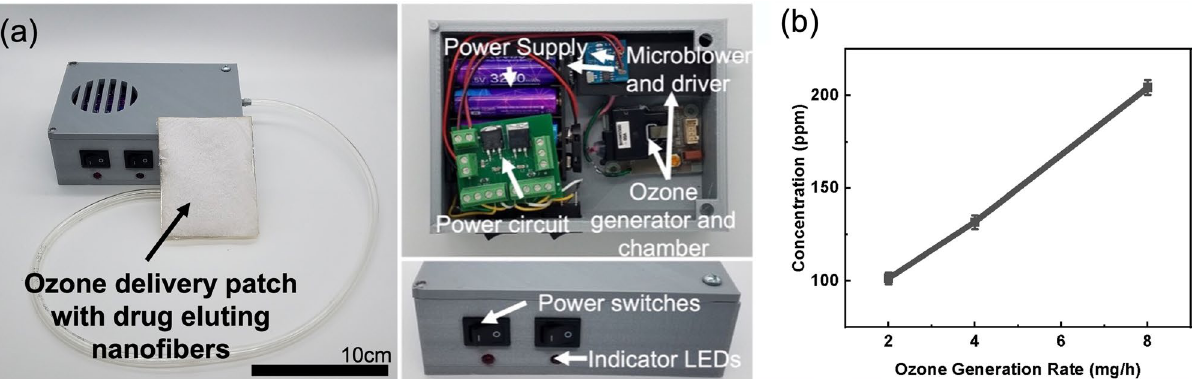
Figure 2. Portable adjunct ozone and topical antibiotic therapy system. ( a ) Ozone wound treatment system designed to administer adjunct ozone and antibiotic therapy topically to dermal wounds. System comprised of portable ozone generation system with microblower for ozone delivery and a porous mesh of drug-eluting PVA nanofibers for antibiotic delivery. Portable rechargeable system is fitted to custom housing and utilizes onboard low-power electronics for. ( b ) Relationship of concentration of ozone created by portable system to the mass generation rate. Error bars denote standard